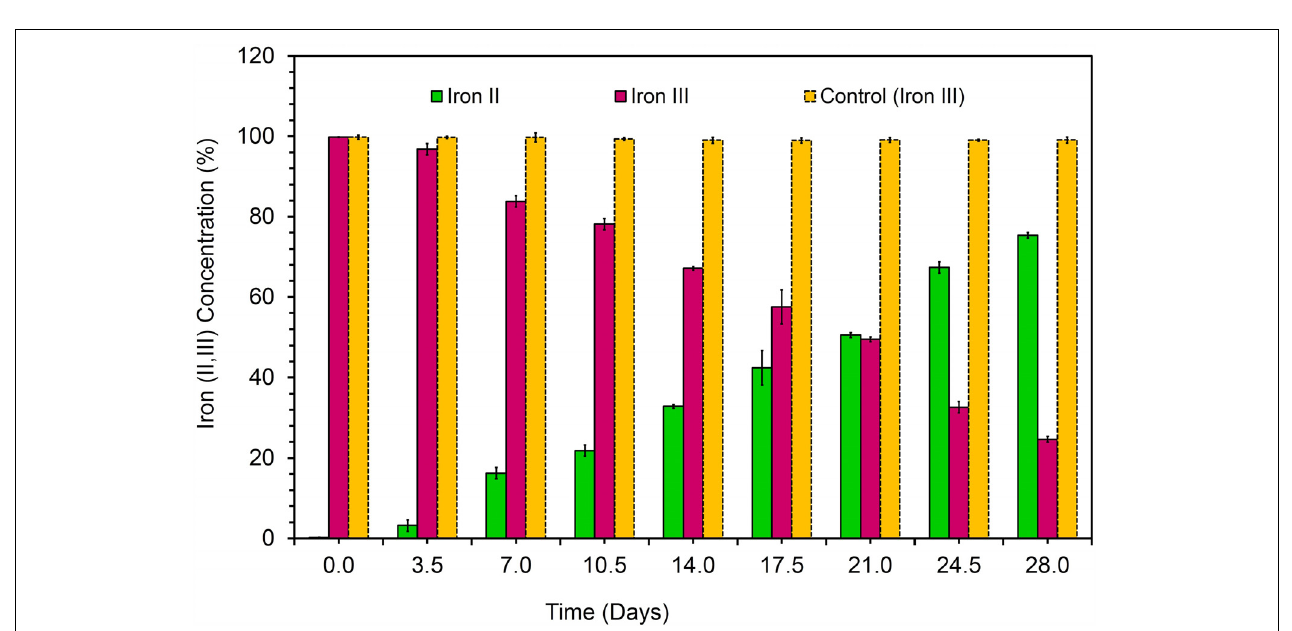
FIGURE 3 | Dissimilatory Fe(III) oxide reduction in anaerobically incubated cells of strain KVM11 at designated intervals (Ferrozine assay, Yellow bar represents the percent of Fe(III) reduction in chemotropically grown control cells; Pink bar represents Fe(III) reduction in anaerobically incubated samples of KVM11; Green bar shows Fe(II) formation in incubated samples of KVM11. Cells were inoculated into an anaerobic vials containing growth medium, electron donor: 20 mM acetate and electron acceptor: 10 mM Fe(III).